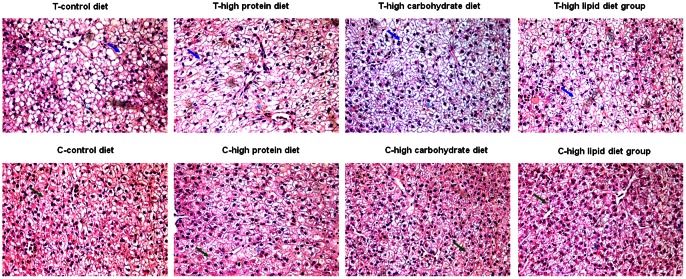
Histological analyses of liver tissues. Liver tissues from 4 different diet treatments were formaldehyde-fixed, followed by staining with Hematoxylin and eosin.The results (75×) from transgenic fish are shown in the upper panels, and wild-type controls with corresponding diet treatments in the lower panels. Arrows in upper panels indicate lipid droplet (blue) and those in lower panels (green) show glycogen deposits.